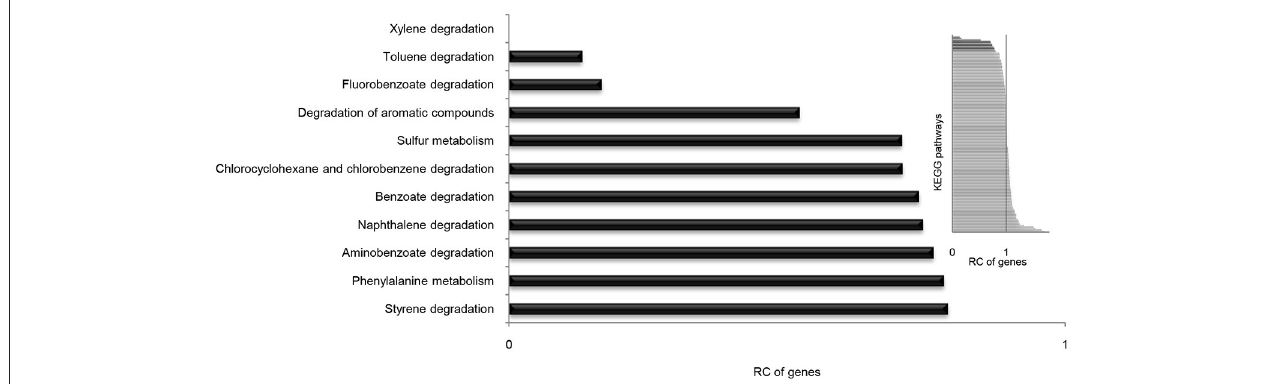
FIGURE 6 | Relative contents (RCs) of gene numbers of KEGG metabolic pathways in Pseudomonas sp. strain SI-3. The average gene numbers for each metabolic pathway in strain SI-3 and 20 P. stutzeri strains were set to 1, after which the gene numbers of corresponding KEGG metabolic pathways of SI-3 were normalized. All pathways of SI-3 were ranked based on the RC of genes. The pathways with RCs between 0.8 and 1.2 were omitted to make the results clear. The embedded panel in the upper right was the entire profile of all pathways of SI-3.